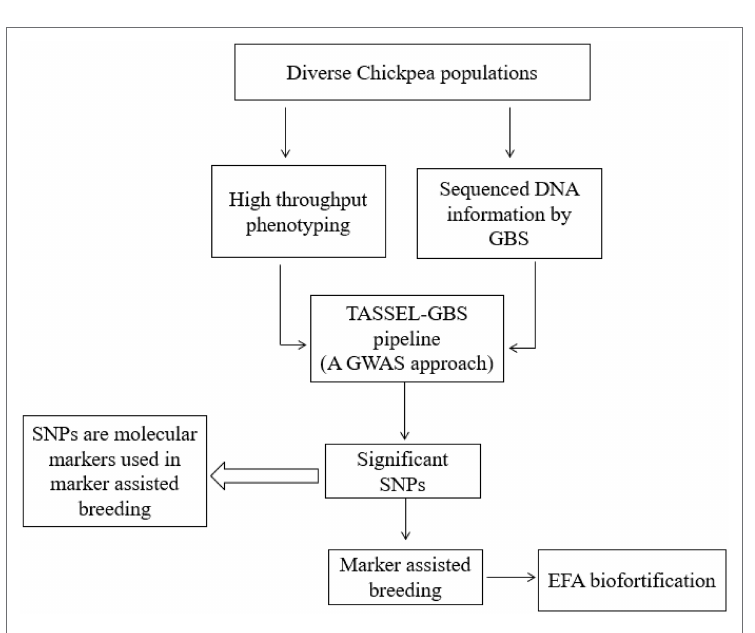
FIGURE 5 | Genetic biofortification of EFA in chickpea.